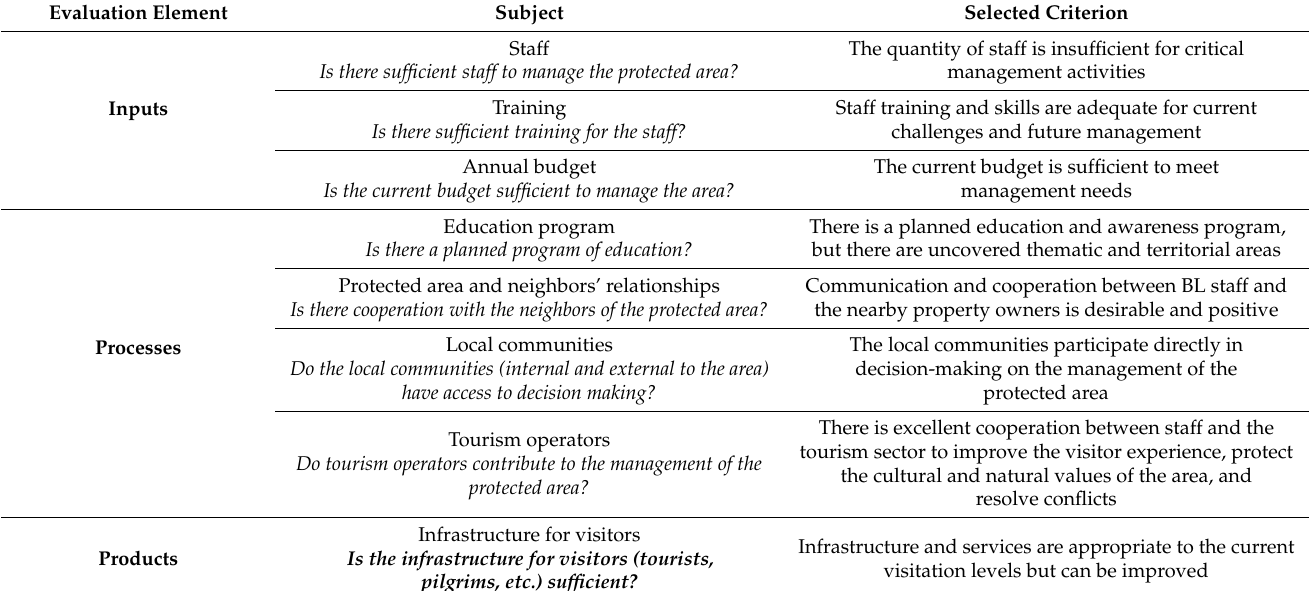
Table 3. Infrastructure assessment and participation based on WCPA & WWF [40,41].